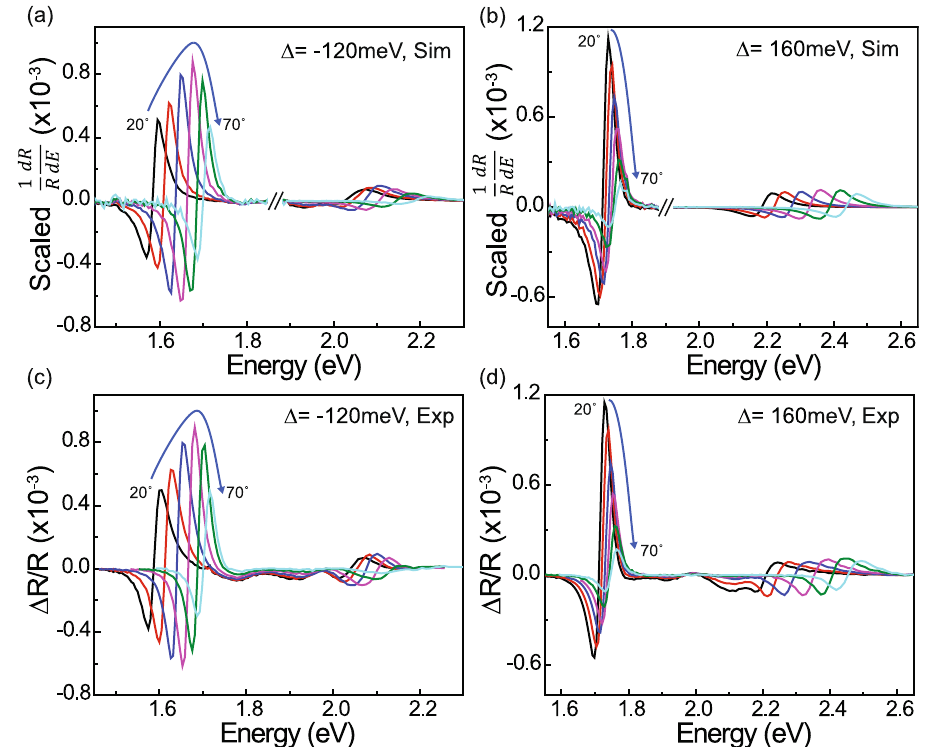
Fig. 4 | Derivative scaling analysis of polariton electrore fl ectance. Scaled deri- amplitudeofthecorrespondingexperimentalelectrore fl ectancespectrain c and d ; (cid:1) (cid:3) the scaling factorscorrespond to the fi eld-induced UP and LP energy shifts at each , for the negatively- ( a ) and vatives of the experimental re fl ectivity data, 1 R dR dE angleasdiscussedinthetext.Notethat c , d arereproducedfromFig.3e,hforease positively-detuned ( b ) 40wt% SQ microcavities. The LP and UP features in a and b are scaledindependently(as indicated by the line breaks at1.85eV)to match the of